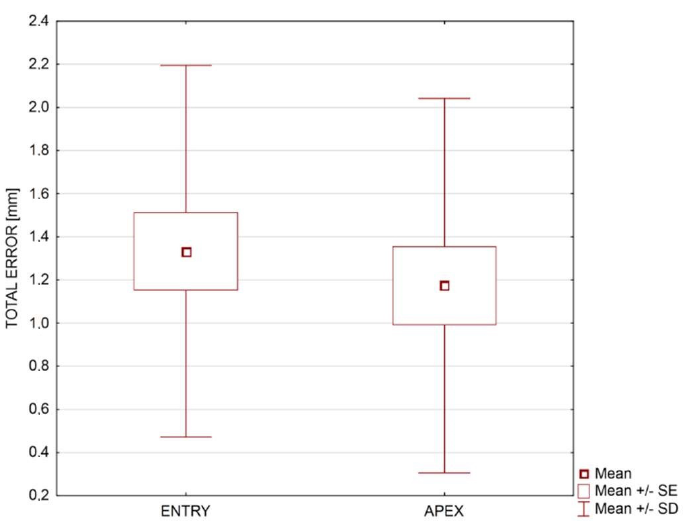
Figure 6. Comparison of the TOTAL ERROR parameter at the entry point (ENTRY) and at the apex of the implant (APEX). For a deeper analysis of the dependence of the total error (TE) at APEX from TE at ENTRY, the correlation of the values was verified, and is presented in Figure 7.